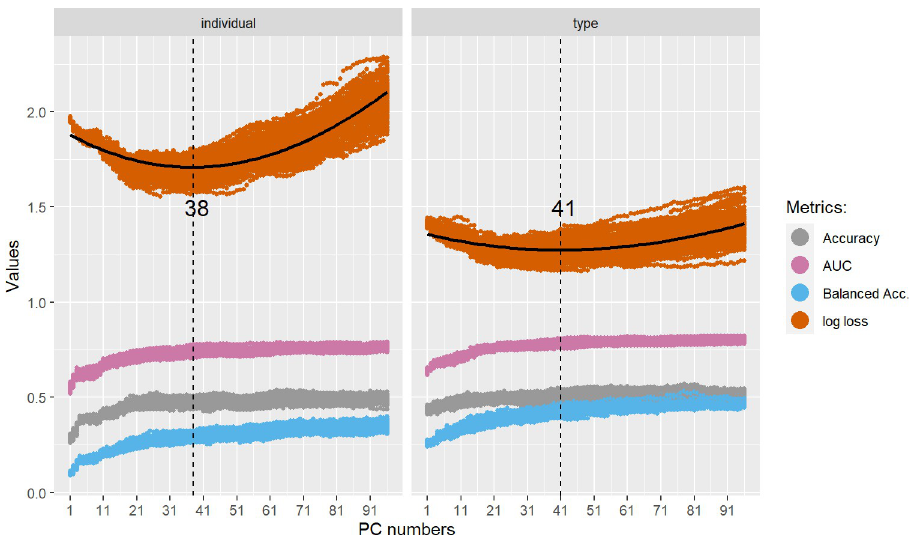
Fig 15. Scatterplots showing the evolution of the DFA performance as a function of the number of PC considered using four different performance metrics (see “Automatic classification approaches and evaluation methodology” for details about these metrics). Left. Classification of individual signature. Right. Classification of call